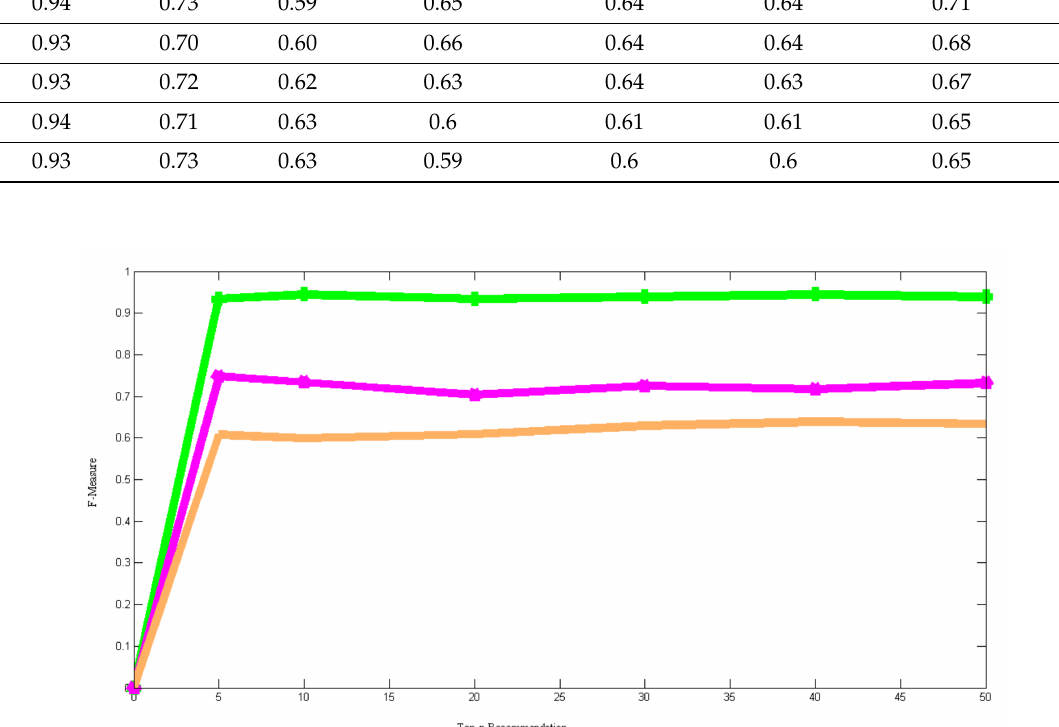
Figure 8. F-Measure according to the Topn